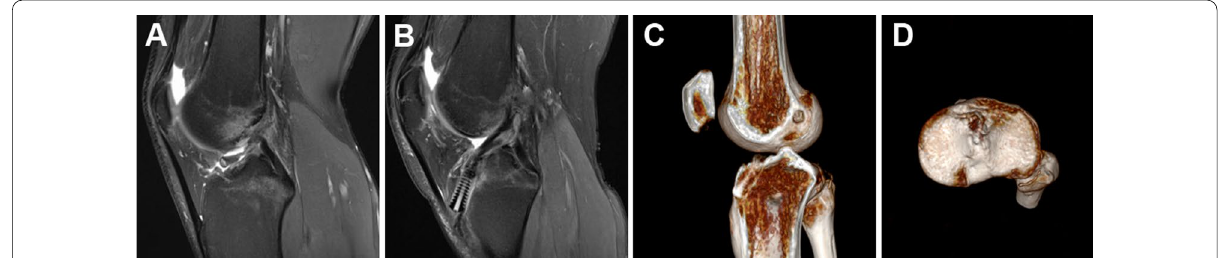
Fig. 5 Radiological examination of STSB ACL reconstruction. A Preoperative MRI showed ACL rupture. B MRI at the last follow-up showed complete graft healing. C 3D CT showed the femoral socket and the tibial tunnel. D 3D CT showed the tibial socket